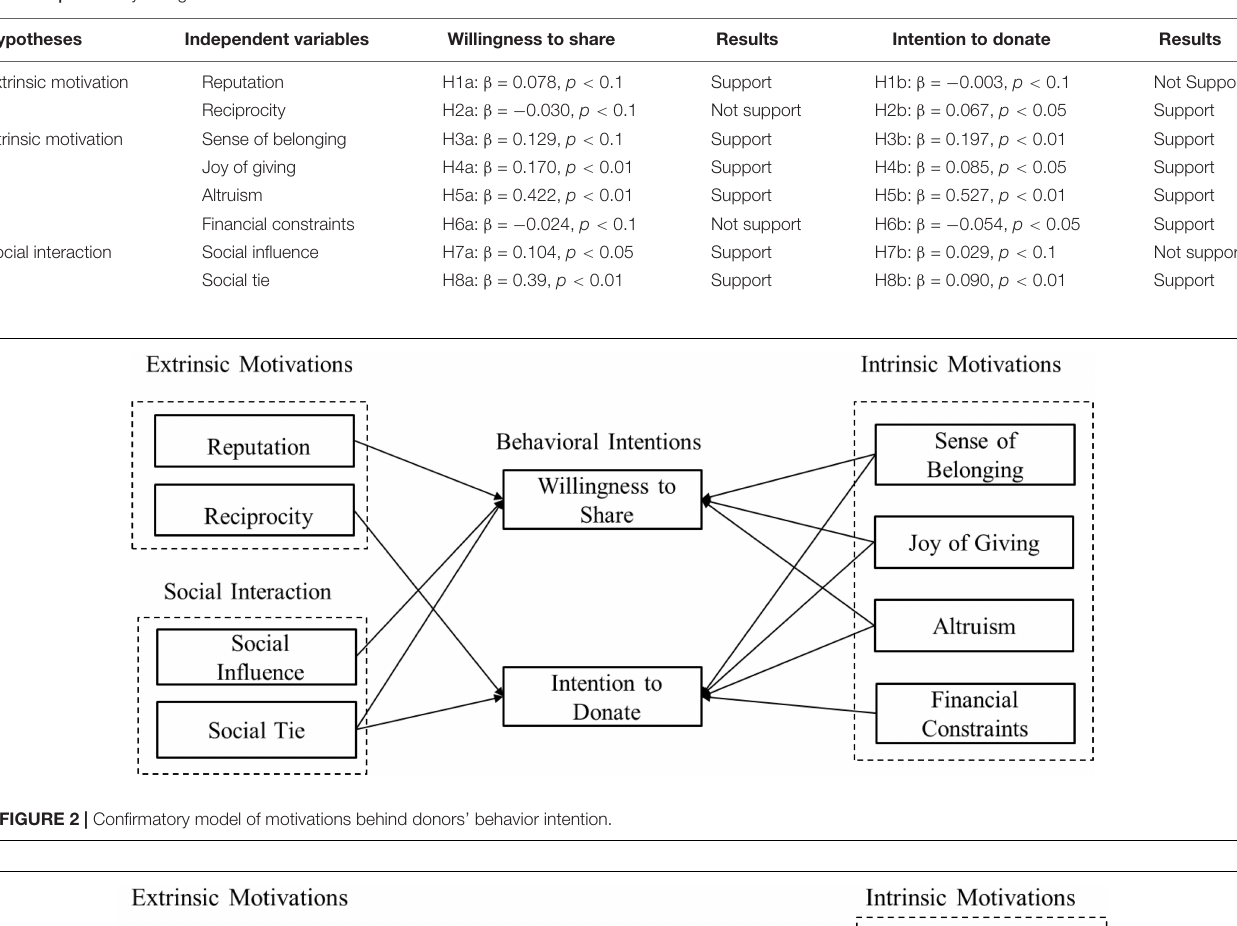
TABLE 5 | Summary of regression results.